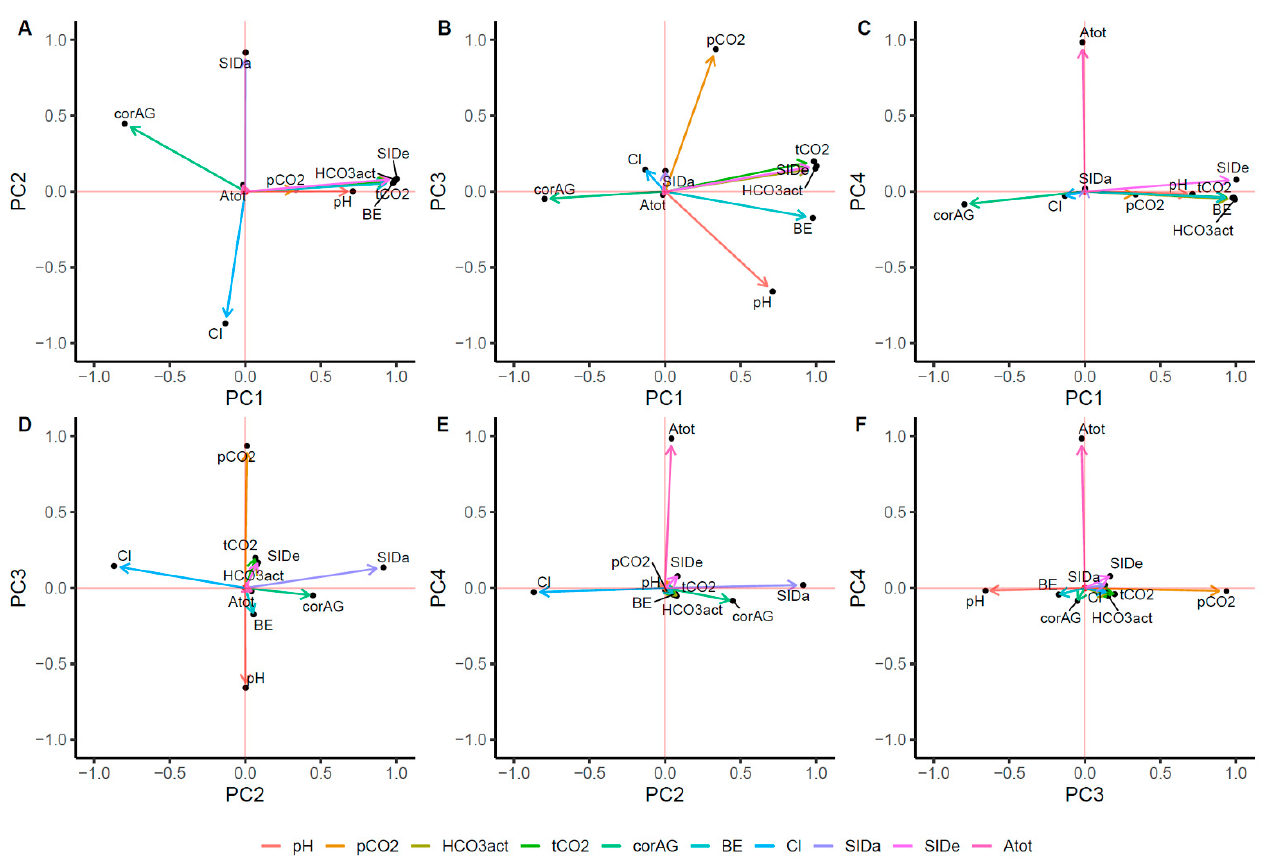
Figure 3. Factor loadings after principal component analysis. The figures representing factor loading in Cartesian coordiates between PC1 and PC2 ( A ), PC1 and PC3 ( B ), PC1 and PC4 ( C ), PC2 and PC3 ( D ), PC2 and PC4 ( E ), and PC3 and PC4 ( F ). Table 4. Results of principal component analysis.